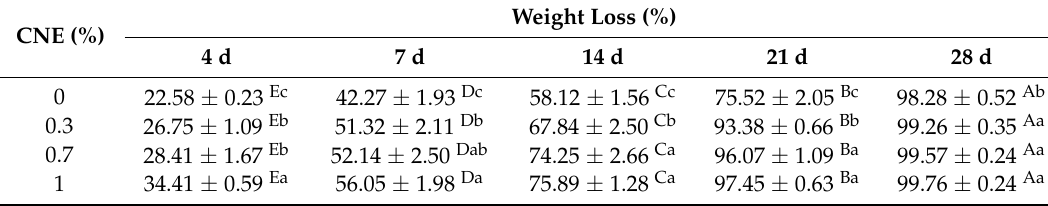
Table 5. Biodegradability of ABS films containing various amounts of cocoa nibs